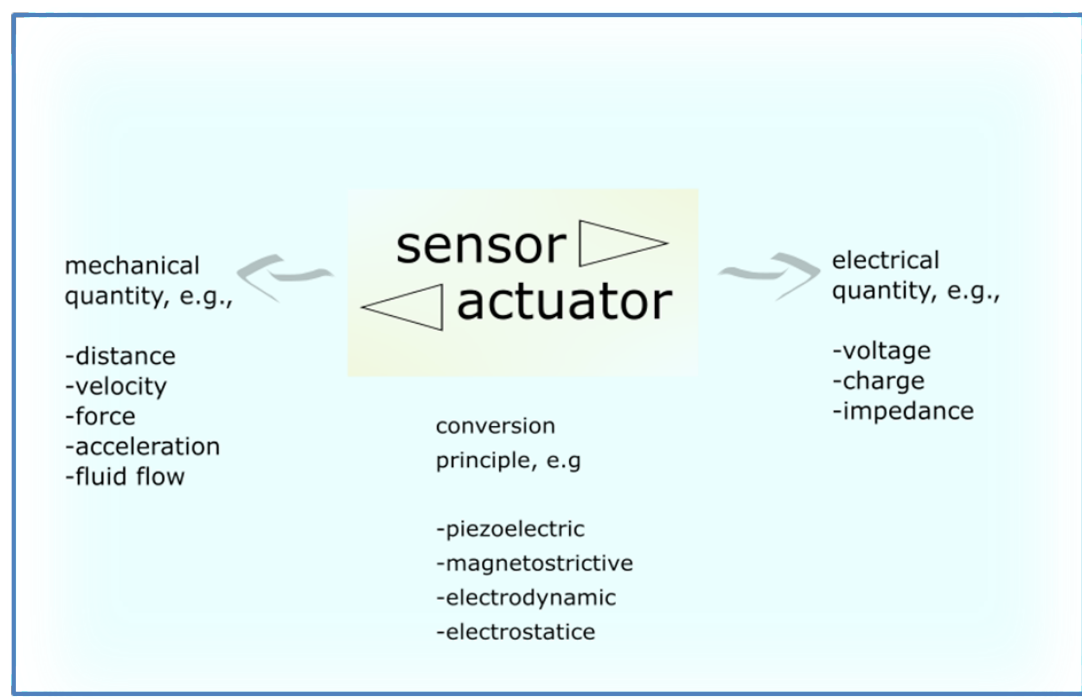
Figure 2. Actuators and sensors—a typical transformation of selected quantities.